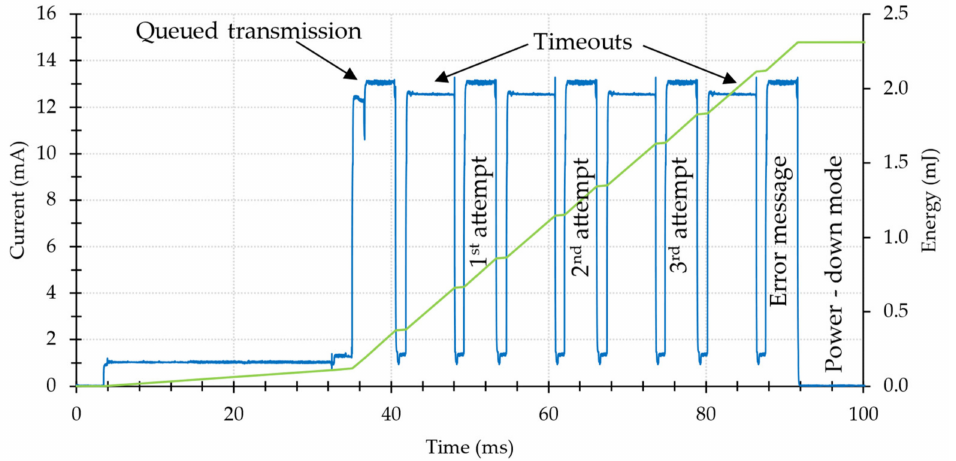
Figure 13. Instantaneous supply current and energy transfer for the SU operating in the communica- tion error mode triggered during